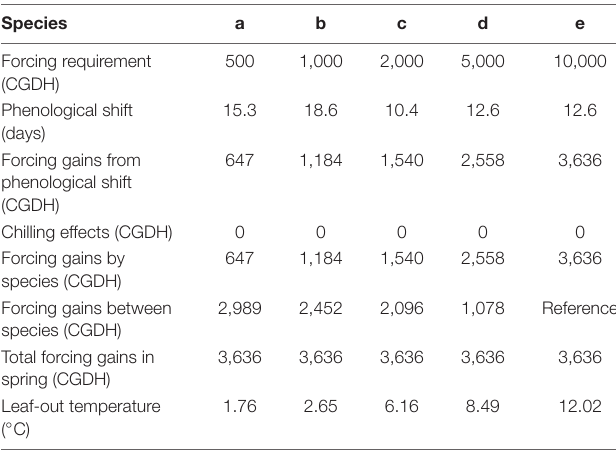
TABLE 1 | Phenological shifts (changes in leaf-out time), forcing gains (changes in cumulative forcing temperatures), and leaf-out temperatures (average temperatures within the window of phenological shifts) for hypothetical species of very early to late spring phenology [500–10,000 cumulative growing degree hours (CGDH > 0 ◦ C) since January 1] in response to 2 ◦ C uniform increases of 2018–2019 winter temperatures in Sault Ste Marie, Ontario,